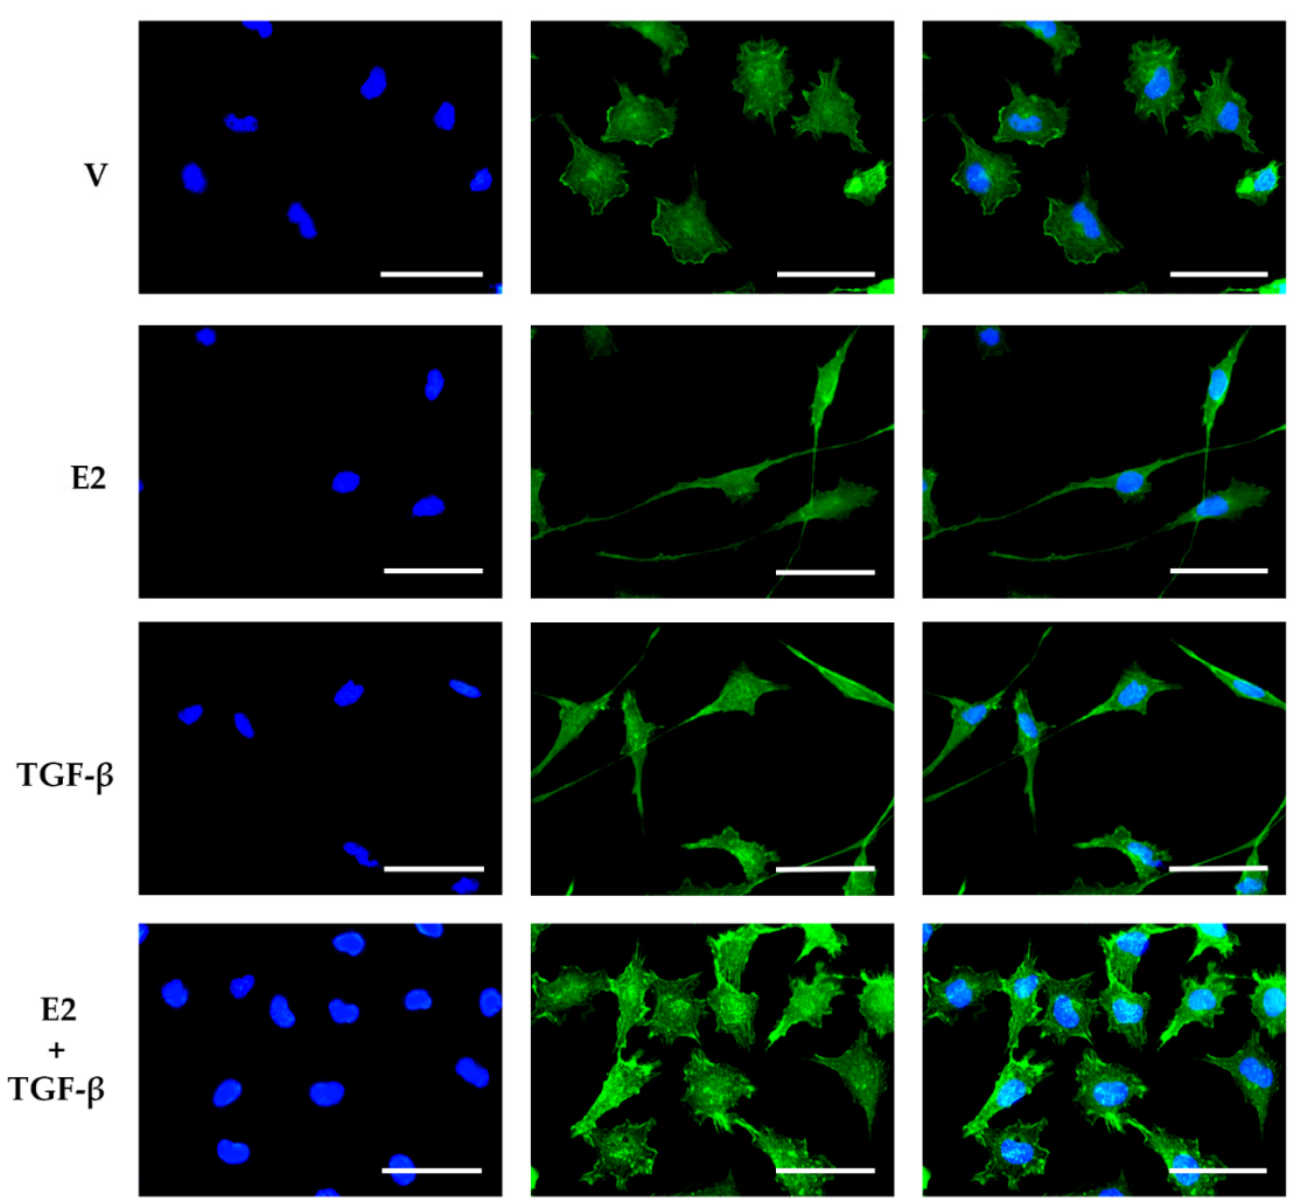
Figure 5. Effects of E2 and TGF- β on actin cytoskeleton reorganization in U251 cells. Actin immunostaining in U251 cells treated with vehicle (V, 0.01% cyclodextrin + 0.0001% BSA), E2 (10 nM), TGF- β (10 ng/mL) and E2 + TGF- β . Scale white bars = 30 µm. Representative images were captured under a fluorescence microscope at a magnification of 400×.